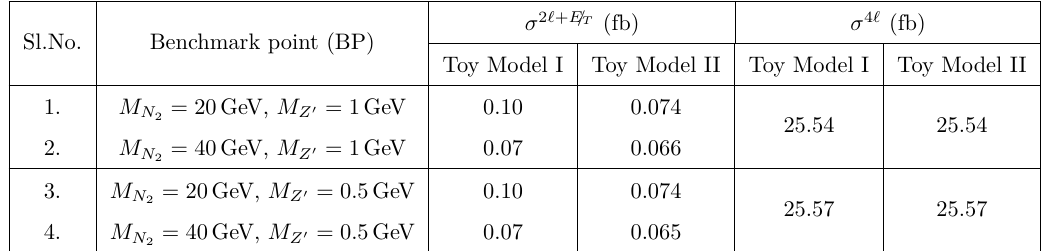
Table 7 . Production cross-section of the dilepton + /E T ( σ 2 ‘ + /E T ) and 4 ‘ ( σ 4 ‘ ) final states for some specific benchmark points of the two toy models. The intermediate channels that lead to such final states are listed in table 5. Please note that the cross-section for the dilepton + /E T channel for Toy Model I quoted here excludes the contribution from the charged Higgs mediated diagram (which we have separately shown in table 6).